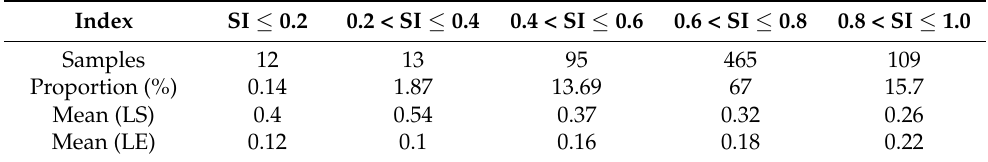
Table 4. Cross-statistical analysis of SI, LE and LS.